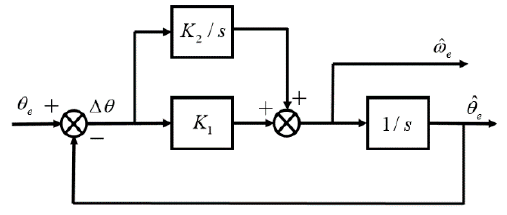
Figure 4. Equivalent structure of phased-locked loop for position tracker.